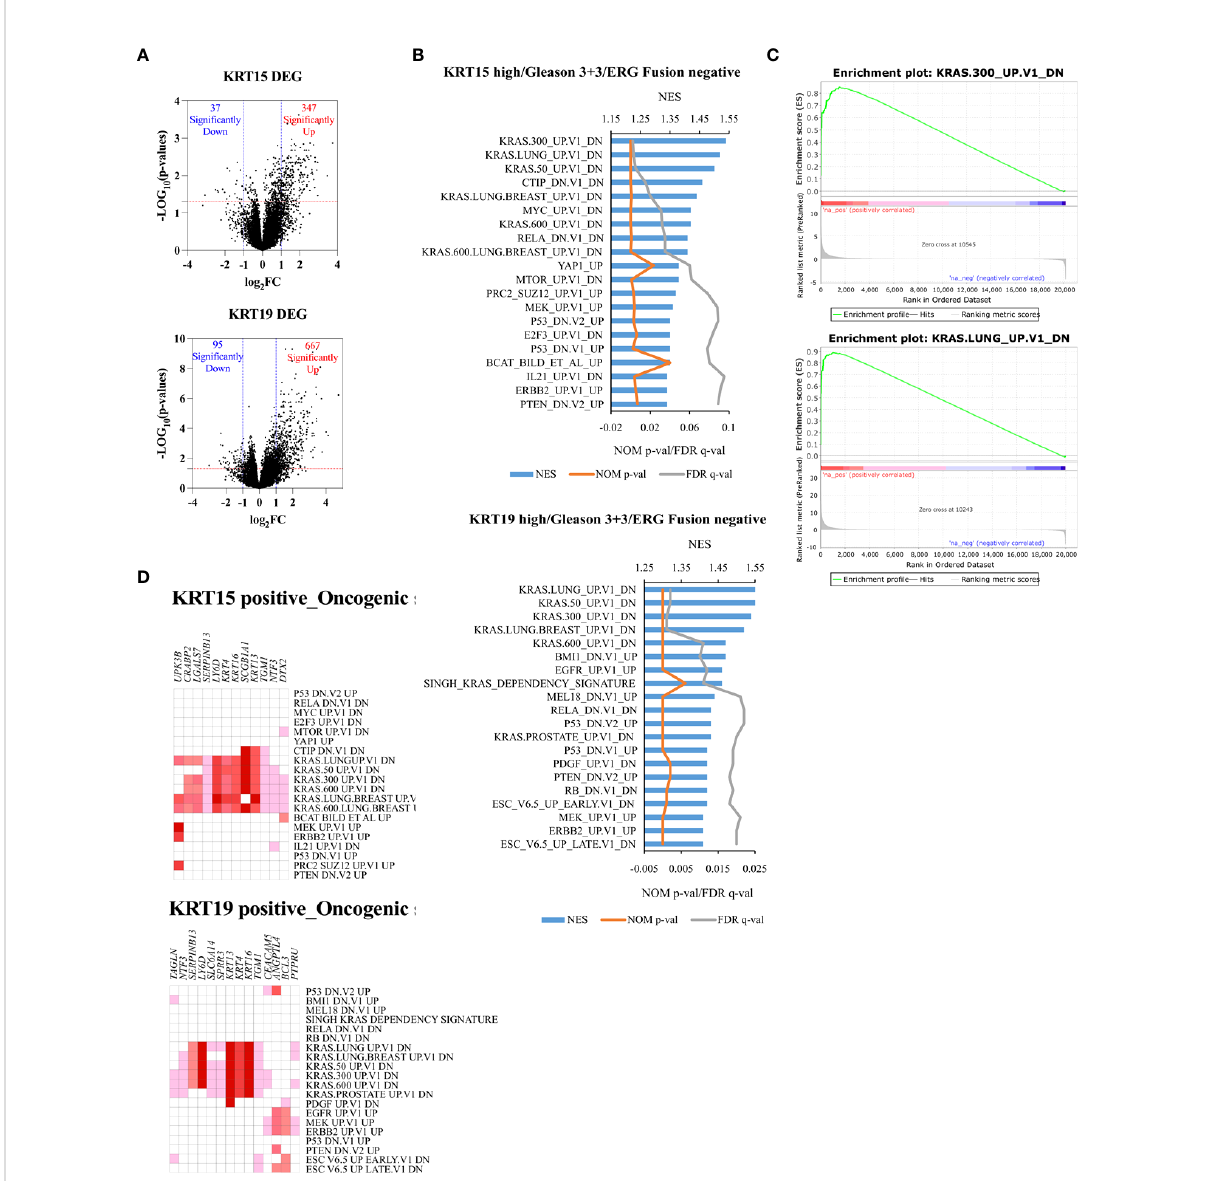
FIGURE 6 Unique oncogenic gene signature associated with KRT15 and KRT19 expression in ERG fusion negative and Gleason 3 + 3 patients. Patients were trichotomized by gene expression into T1 (low expression), and T3 (high expression), and differences in gene expression were determined in low versus high expression patients. (A) DEG in high versus low KRT15 and KRT19 expression. (B) oncogenic gene sets positively enriched in high versus low KRT15 and KRT19 expression. (C) representative enrichment plots. (D) Leading-edge